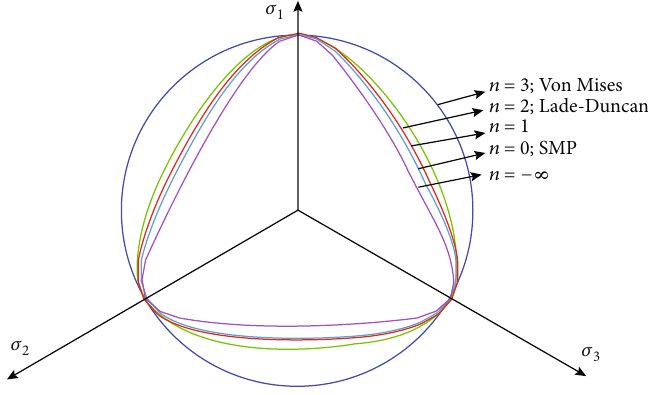
Figure 10: In fl uence of parameter n on the yield curve in deviatoric